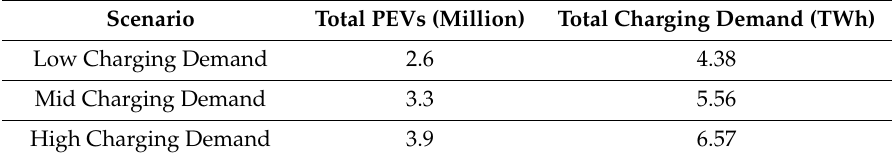
Table 10. Annual PEV Charging Demand in 2030—V2G-SIM